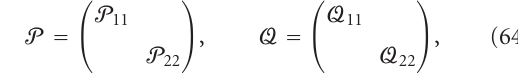
Algorithm 2 [3], that is, balanced truncation method on